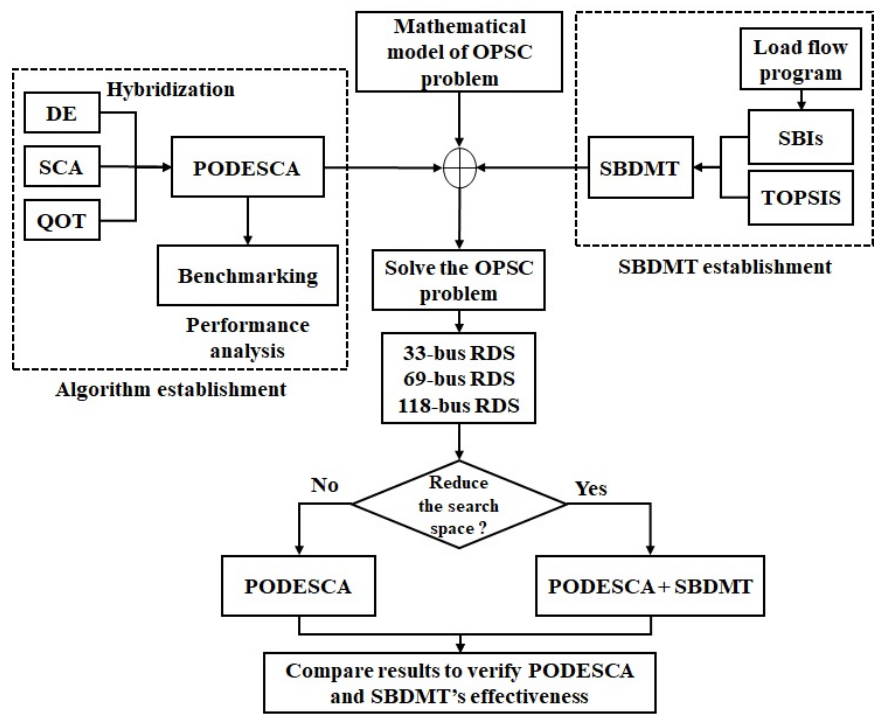
Figure 1. Main research methodology.